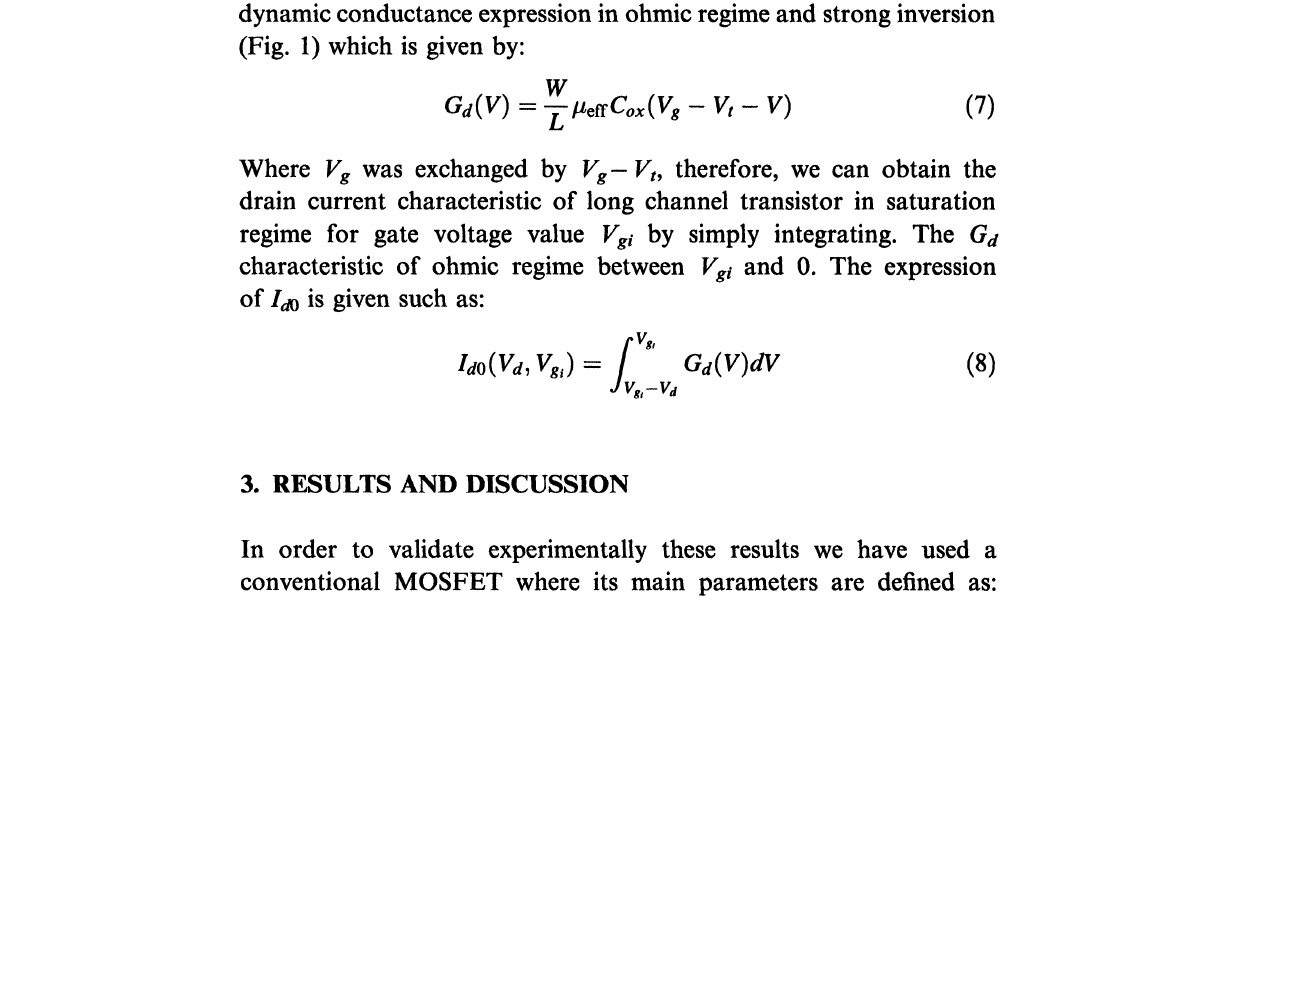
FIGURE Drain current ld versus gate voltage